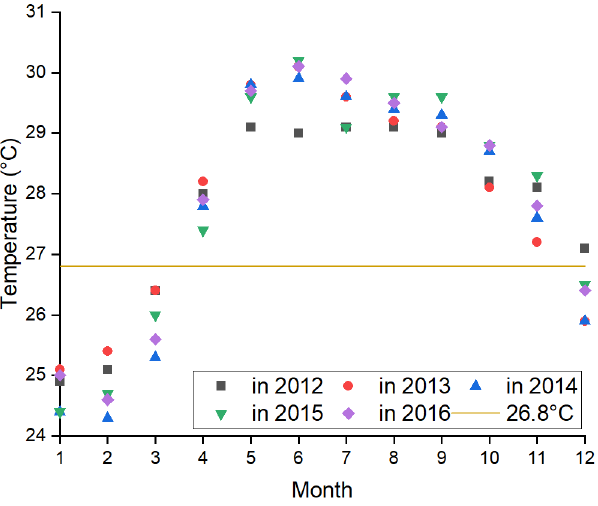
Figure 10. The monthly average surface seawater temperature in the South China Sea.